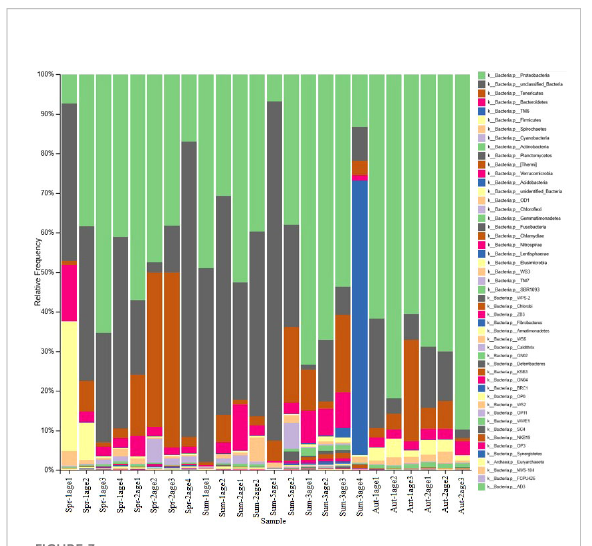
FIGURE 3 Bacterial community composition at the phylum level.